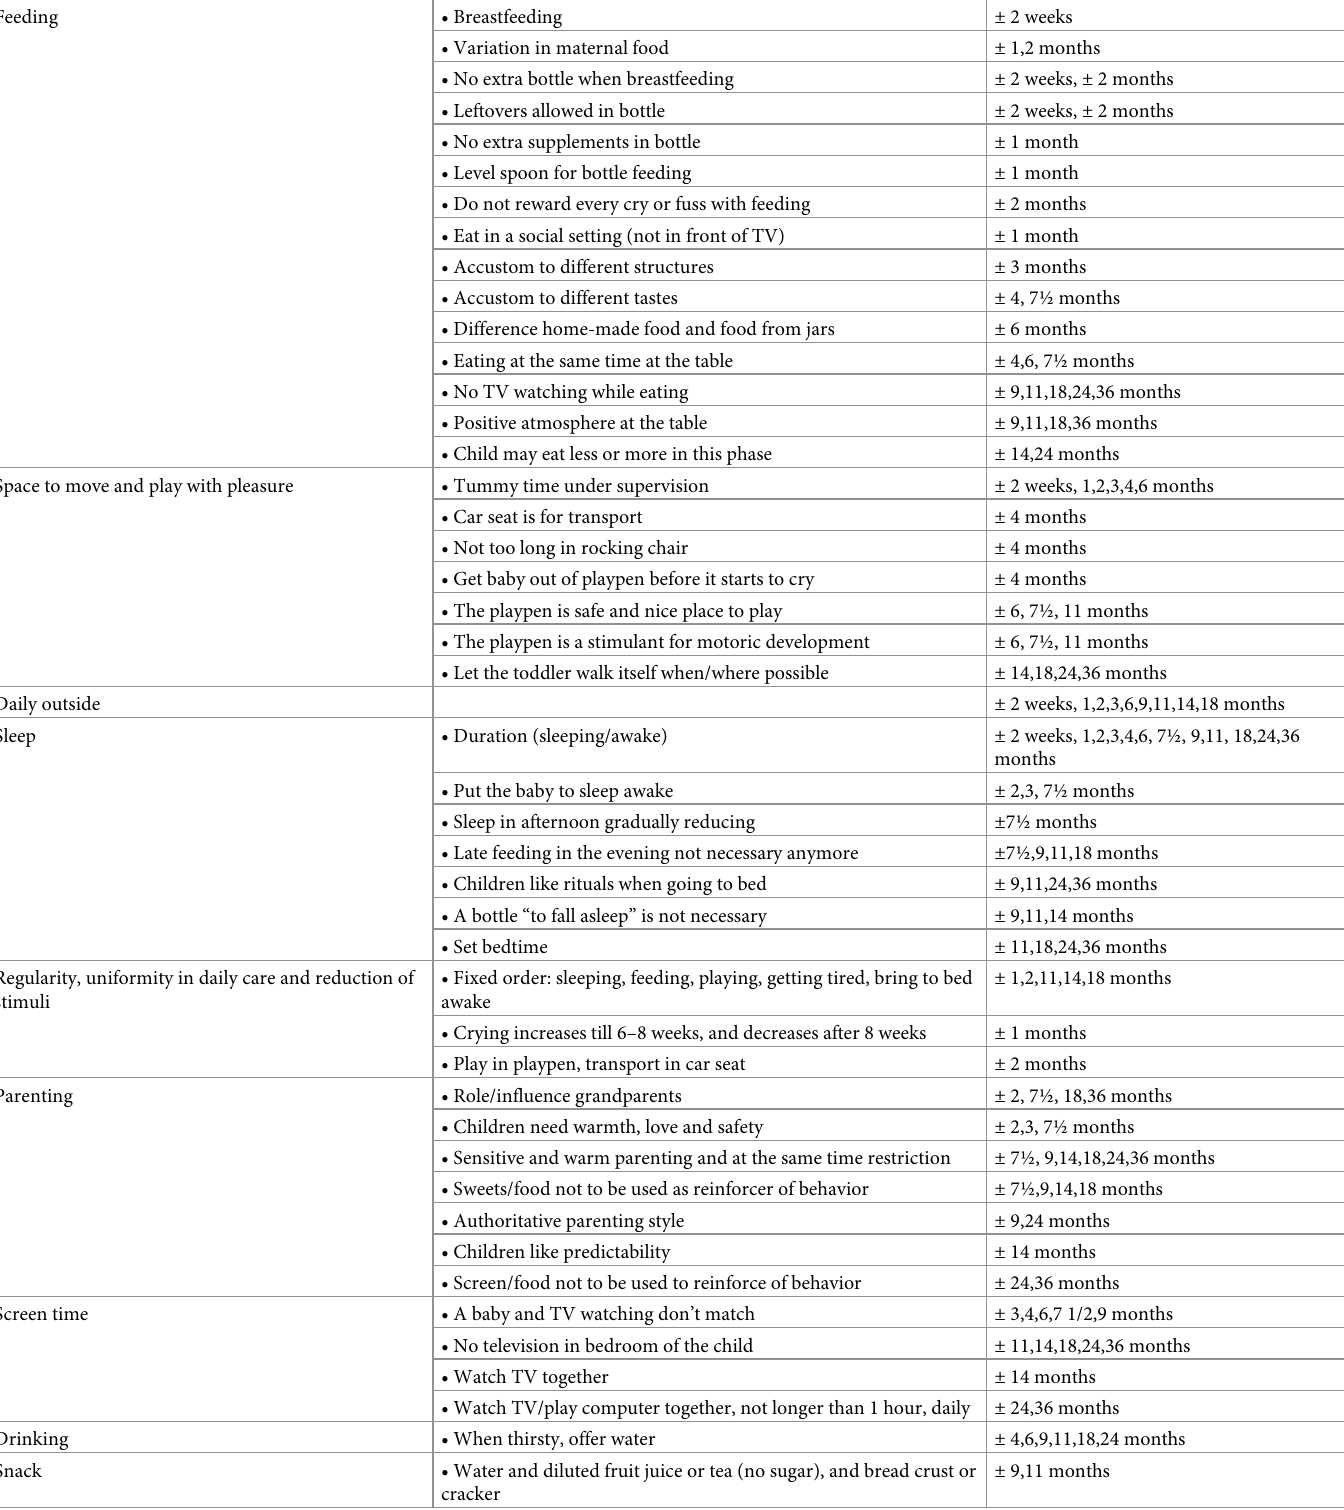
Table 1. Schematic overview of the ‘BBOFT+’ intervention [21].